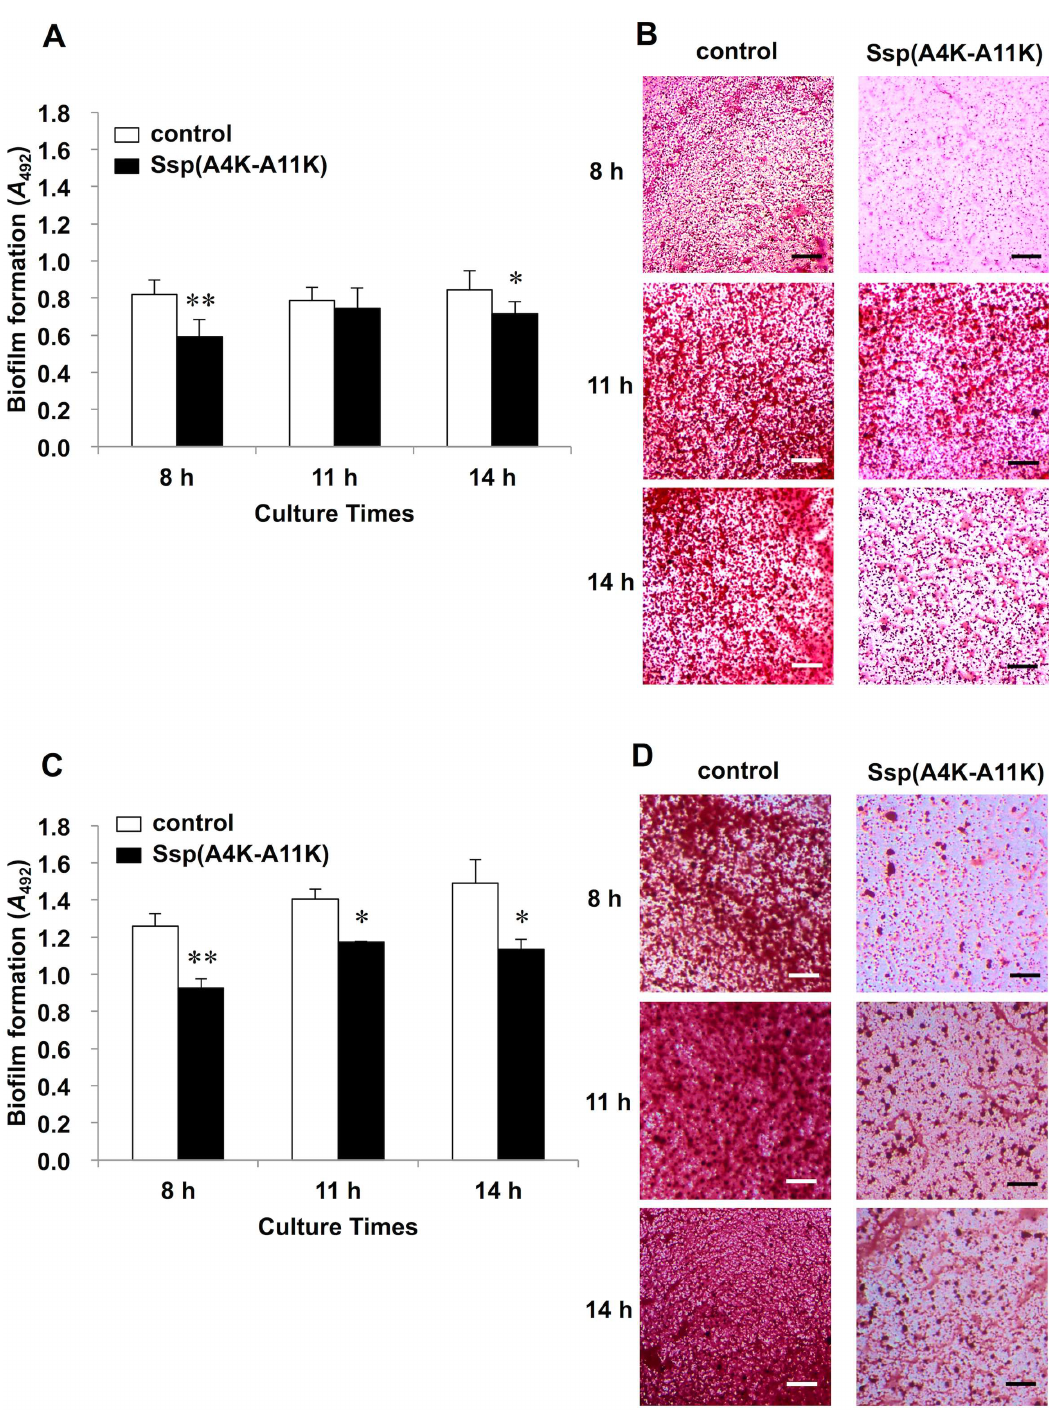
Fig 4. Inhibition using Ssp(A4K-A11K) for S . mutans biofilm formation on s-PS. (A) Biofilms formed duringgrowth in TSBG. (B) Representative photographs of S . mutans biofilms in TSBG on s-PS at 8, 11, and 14 h culture (40 × ). Scale bars, 300 μ m. (C) Biofilms formed during growth in TSBS. (D) Representative photographsof S . mutans biofilms in TSBS on s- PS at 8, 11, and 14 h culture (40 × ). Scale bars, 300 μ m. Biofilms were stainedwith safranin and absorbance at 492 nm was measured. Data are expressedas the means ± SDs of three independentexperiments with technical replicates (vs. control: non-treateds-PS; * P < 0.05, ** P < 0.01).